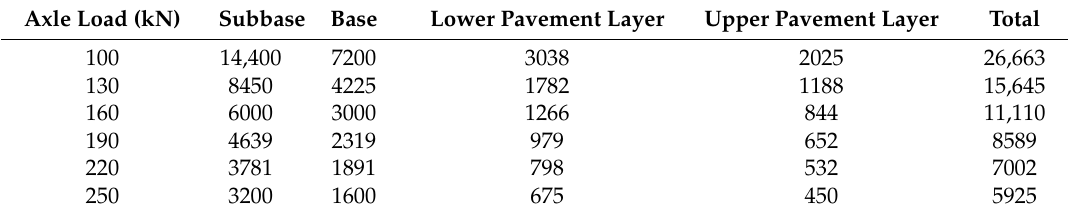
Table 5. Standard axle load times of carrier trucks.